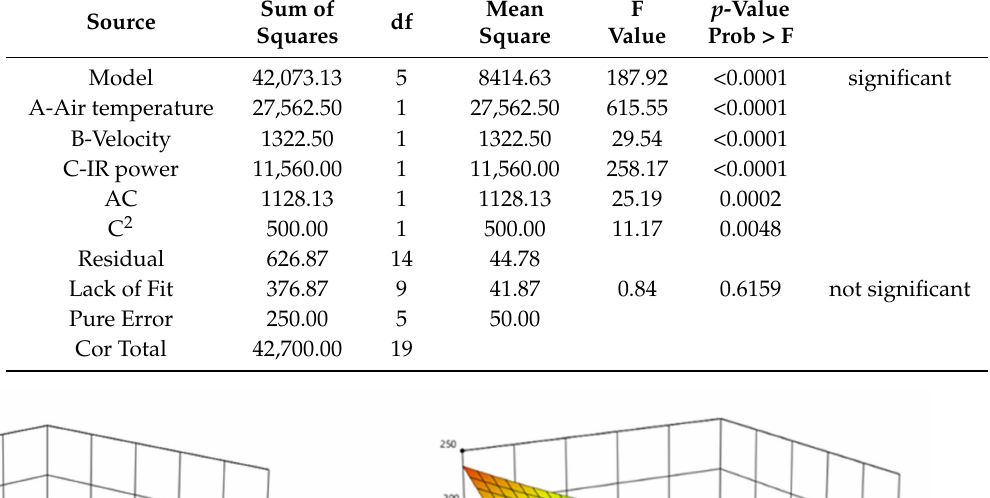
Table 5. Analysis of variance for drying time response using RSM.